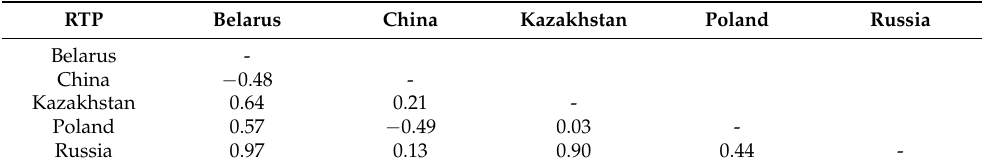
Table 4. RTP index for countries in the New Eurasian Land Bridge (NELB). RTP Belarus